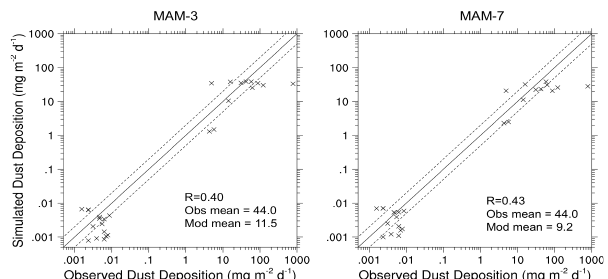
during the HIAPER Pole-to-Pole Observations (HIPPO) campaign observational data was grouped into five latitude zones (67-60 S, 60-20 S, 20 S-20 N, 20- in January 2009 (Schwarz et al., 2010). The observational data were grouped into five latitude zones (67–60 ◦ S, 60–20 ◦ S, 20 ◦ S–